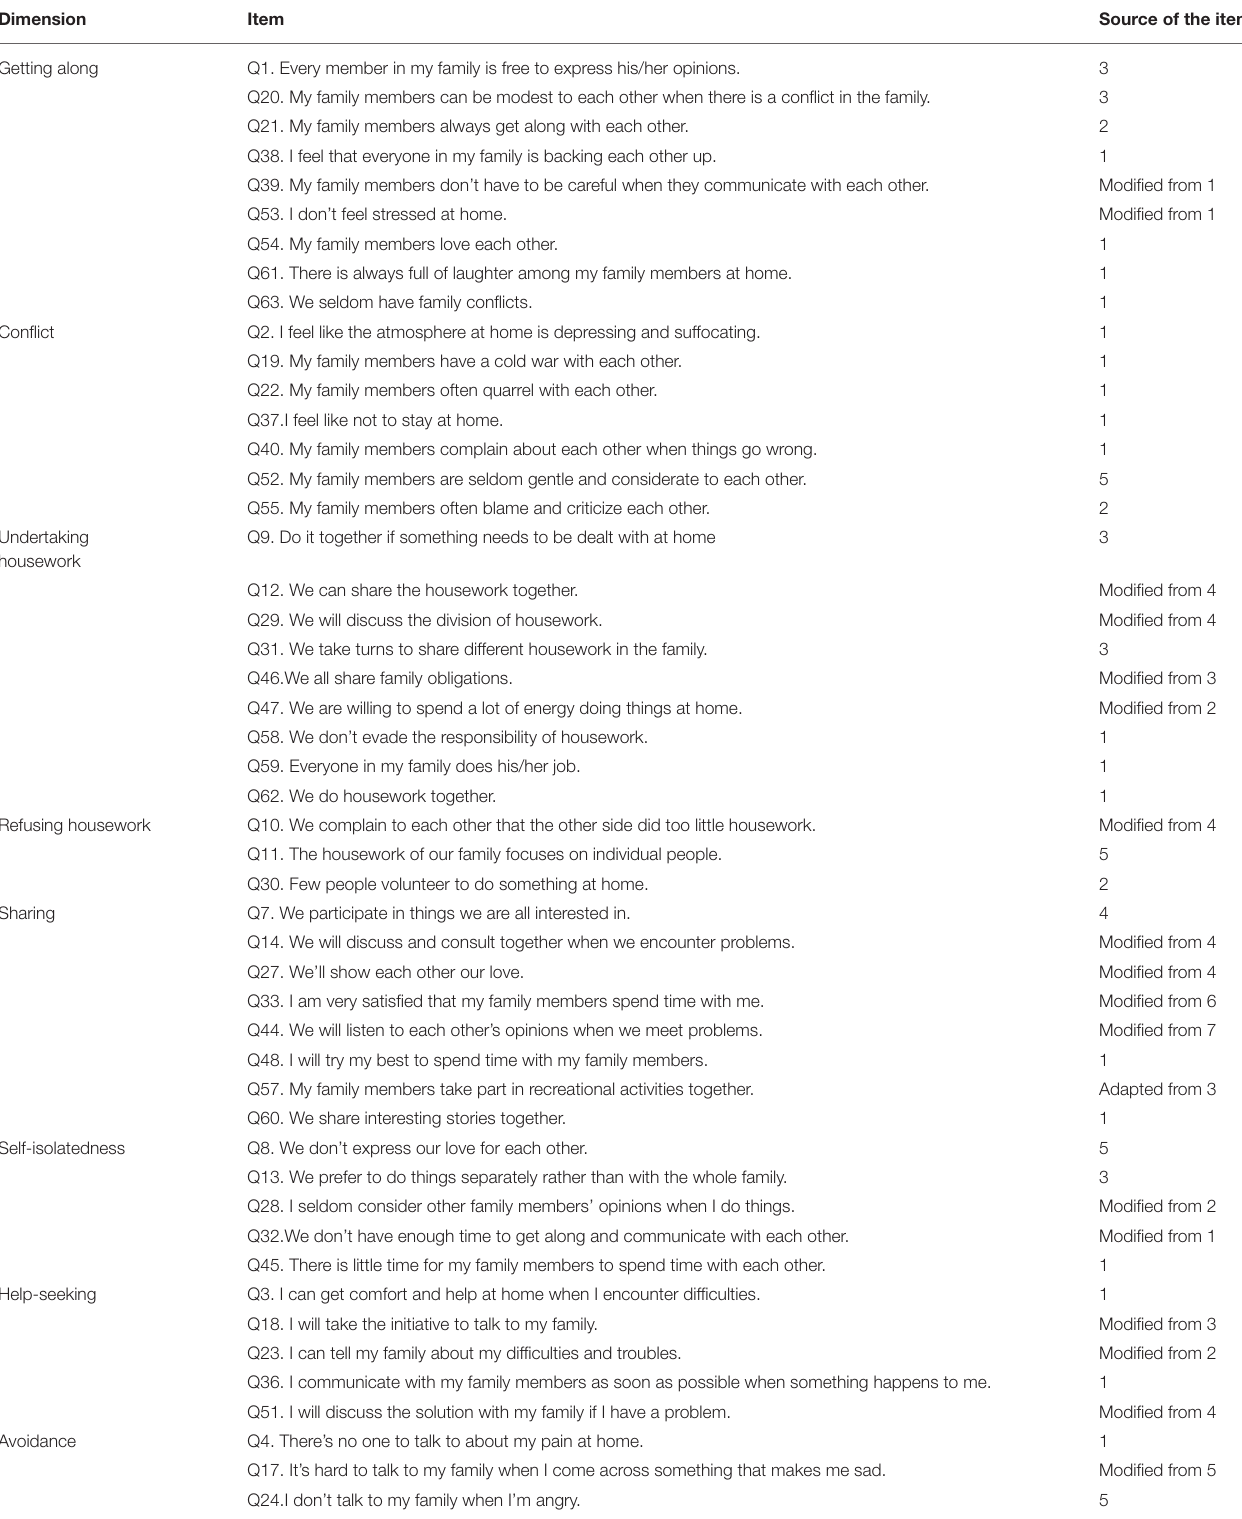
TABLE 1 | Dimensions and items of the initial questionnaire for college students’ experience of family harmony. Dimension Item Source of the item Getting